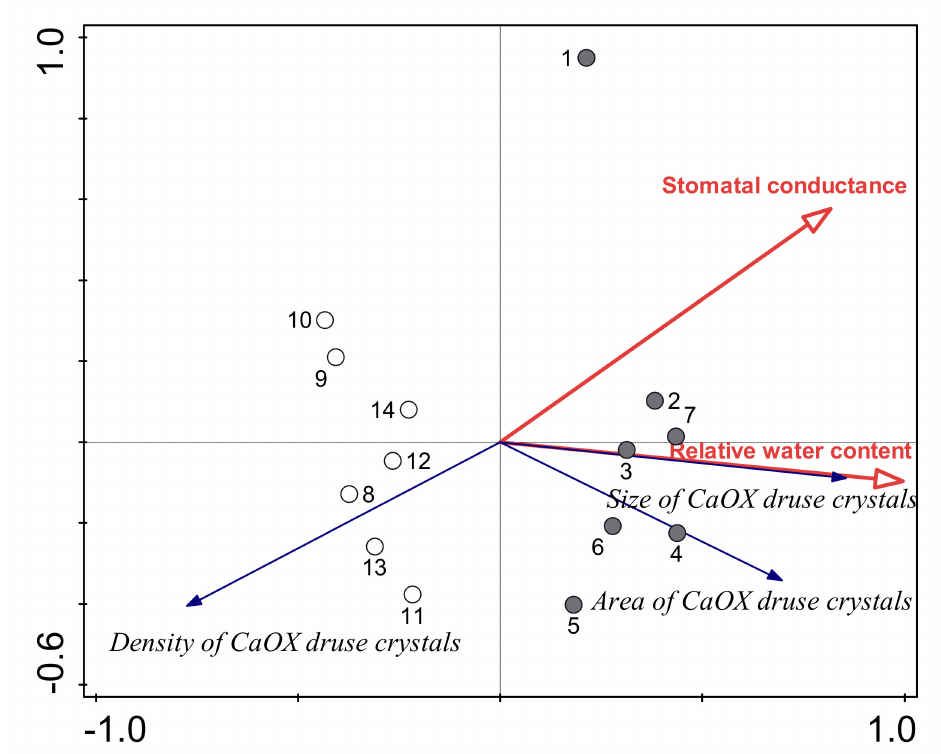
Figure 5. Redundancy analysis plot showing the strengths of the associations between the water status indicators, as relative water content and stomatal conductance, and CaOx druse crystal parameters for the buckwheat leaves. Filled circles, control; open circles, water